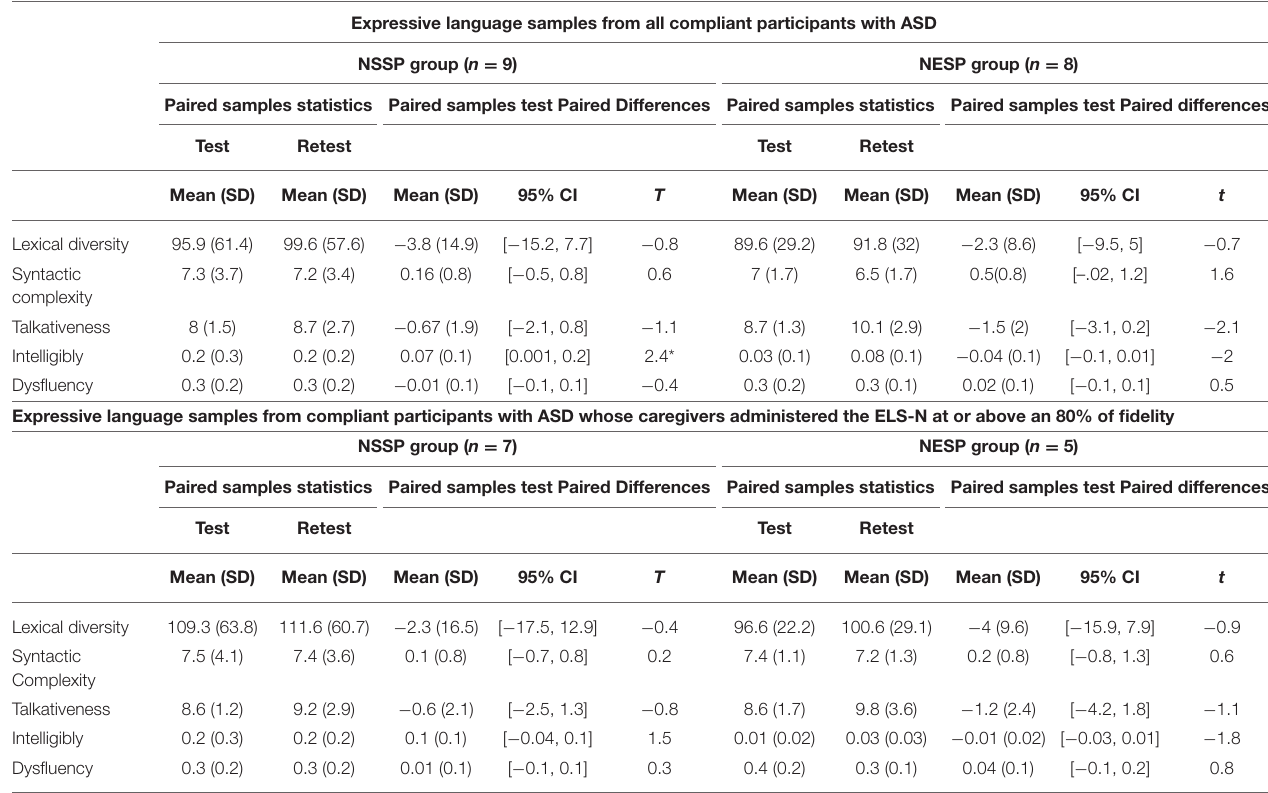
TABLE 5 | T-test for practice effects on test-retest administrations over the 4-week interval. Expressive language samples from all compliant participants with